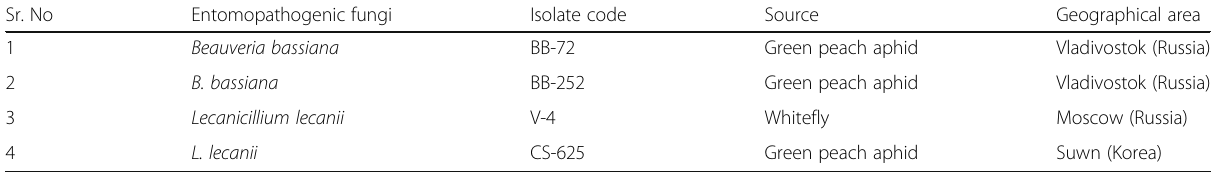
Table 1 Detail of entomopathogenic fungi used in the study Sr.